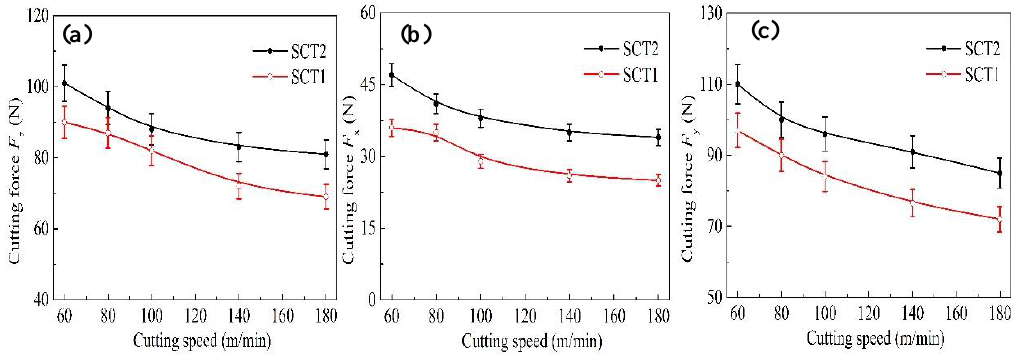
Figure 8. Cutting forces at different speeds with SCT1 and SCT2 in dry cutting of hardened steel ( a ) main force F z , ( b ) axial thrust force F x , and ( c ) radial thrust force F y ( a p = 0.2 mm, f = 0.1 mm/r, cutting time 5 min).